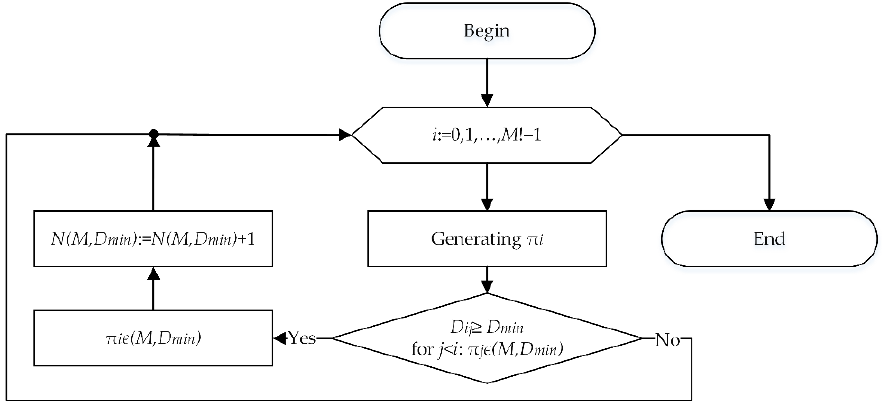
Figure 2. Algorithm to generate a set of codewords without storing the full set of permutations. Table 1. Values of N ( M , D min ) , σ ( N ( M , D min )) , and N max ( M , D min ) for M = 7 and D min = { 4,5,6 } . At the same time, the uniqueness check of the generated permutation is additionally implemented in the new block. Table 1 shows estimates of the mathematical expectation D min 4